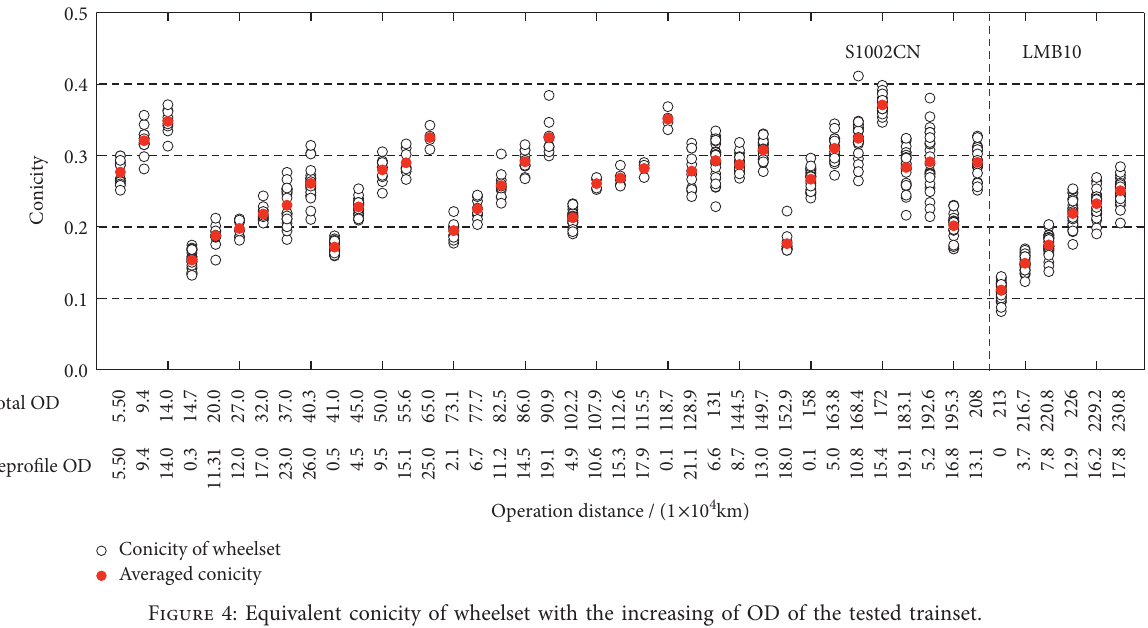
Figure 4: Equivalent conicity of wheelset with the increasing of OD of the tested trainset.